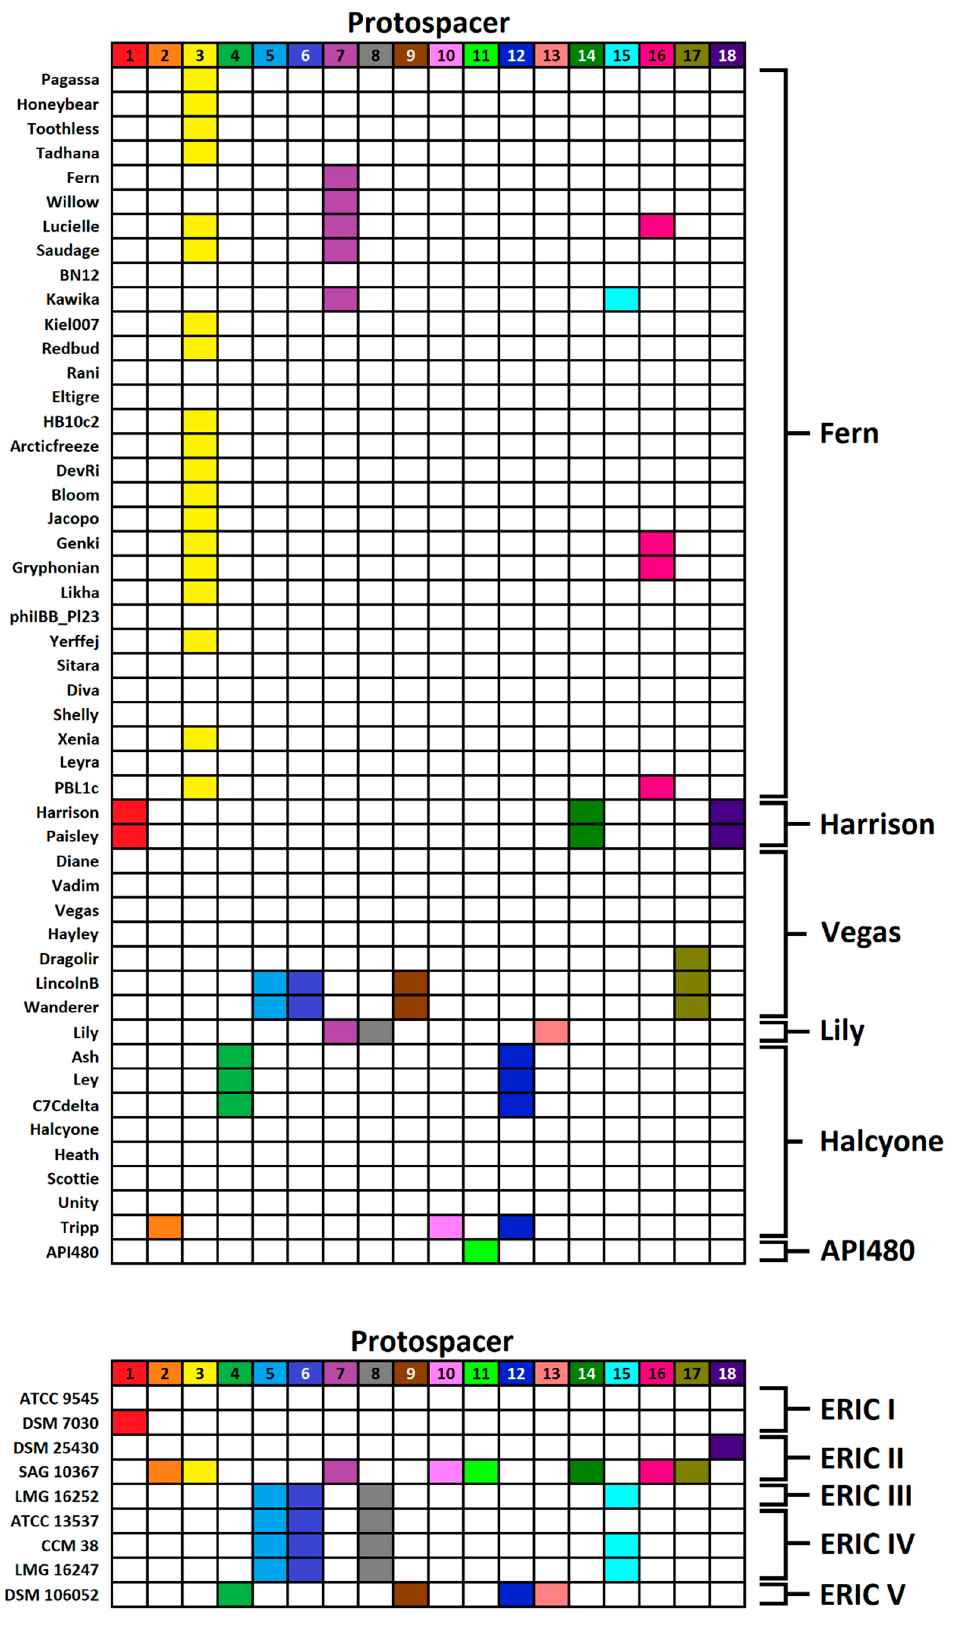
Figure 2. Distribution of the 18 protospacer sequences in P. larvae strains and P. larvae phages.